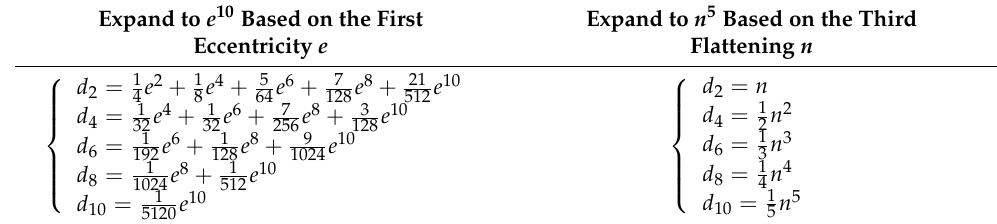
Table 9. Coefficients in Equation (29).